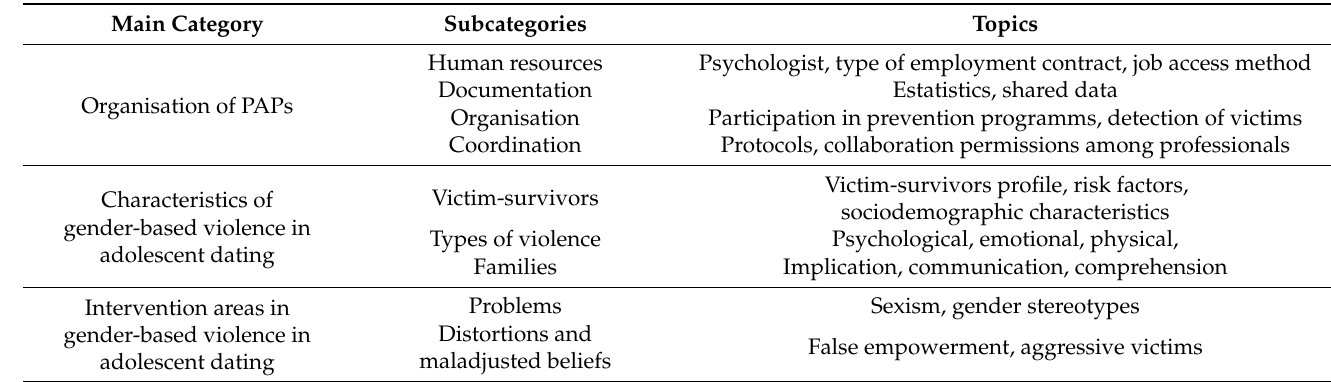
Table 3. Analysis categories and